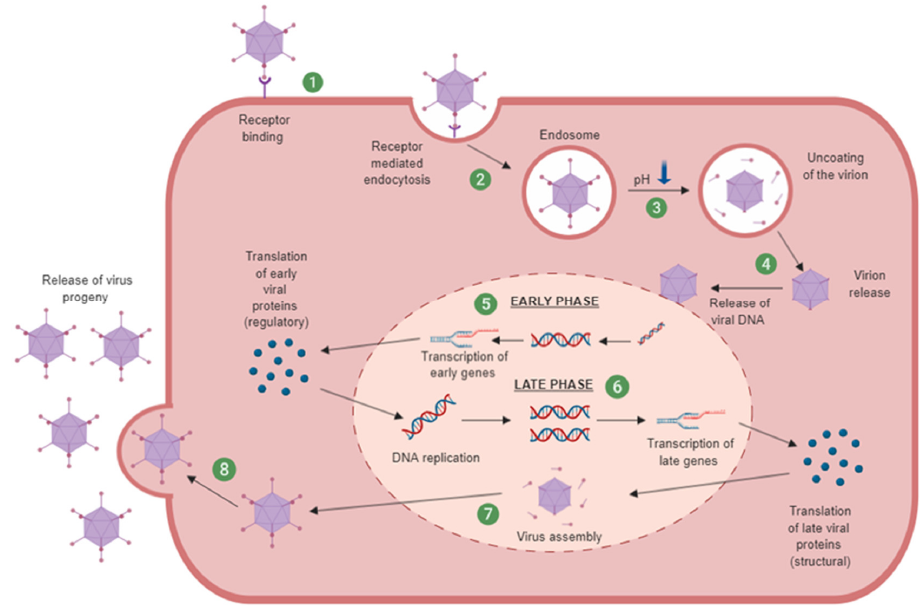
Figure 2. Adenovirus replication cycle. ( 1 ) Virus attachment to receptors on the host cell